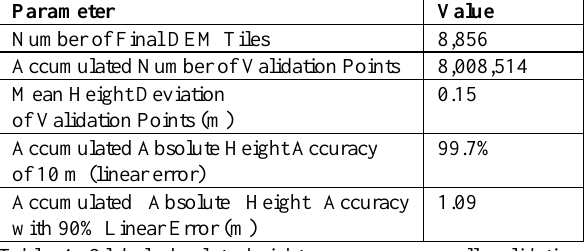
Table 4. Global absolute height accuracy over all validation points (status February